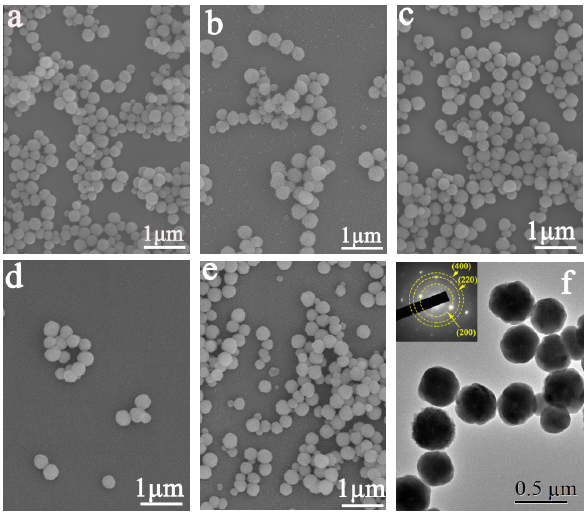
Figure 1. FE-SEM ( a – e ) and TEM ( f ) micrographs showing morphologies of the as prepared ( a,f ) Eu 3 + -, ( b ) Tb 3 + -, ( c ) Ce 3 + -, ( d ) Er 3 + -, and ( e ) Tm 3 + -doped α -NaYF 4 samples, respectively. The inset in ( f ) is the selected area electron di ff raction (SAED) patterns of Eu 3 + -doped